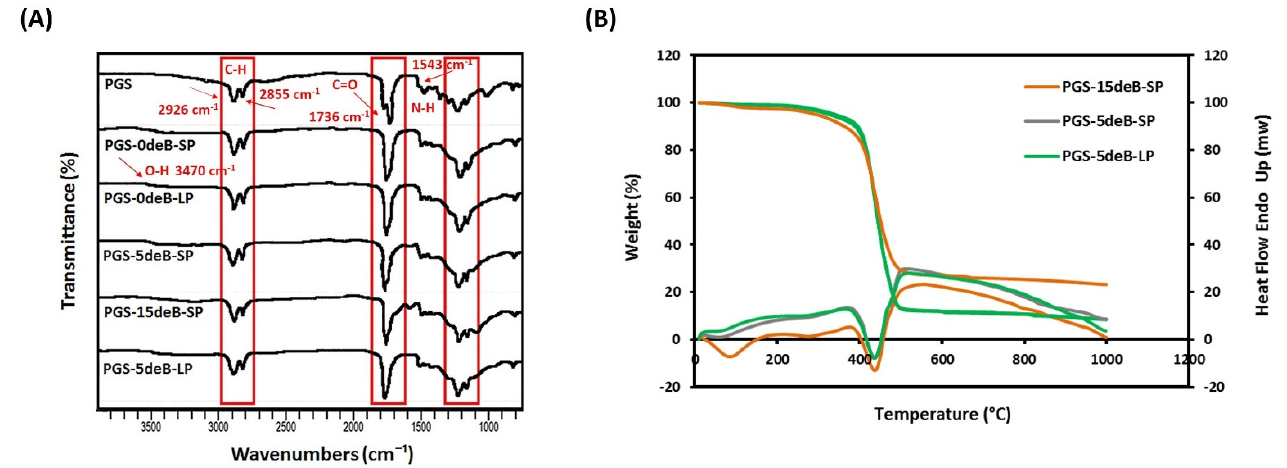
Figure 2. ATR-FTIR spectra: the cured PGS film, the porous plain scaffolds PGS-0deB-SP, and PGS-0deB-LP, and the decellularized bone incorporated scaffolds PGS-5deB-SP, PGS-15deB-LP, and PGS-5deB-LP ( A ); DSC/TGA thermograms of the PGS-deB blend scaffolds ( B ).